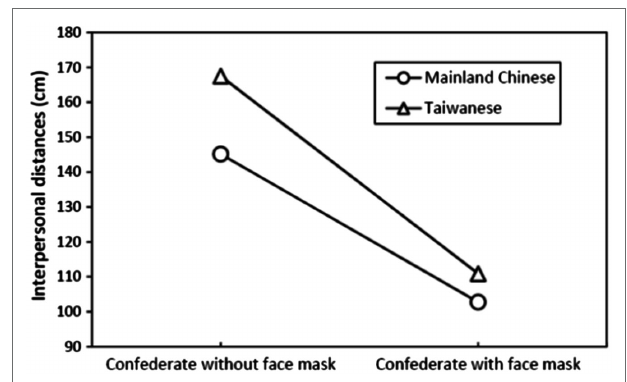
FIGURE 3 | Interaction effect of region and face mask on interpersonal space